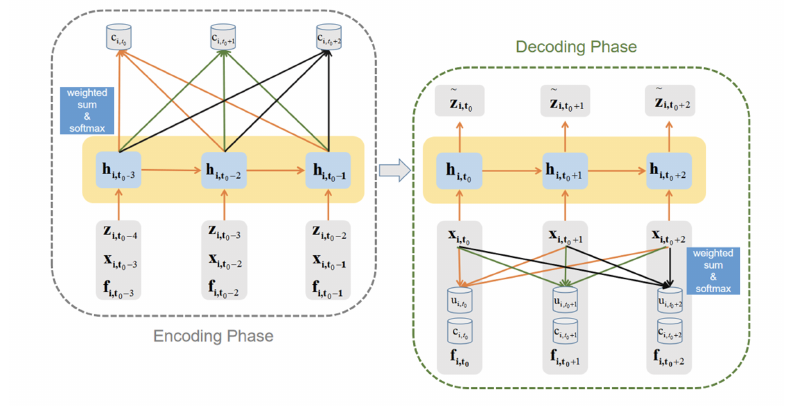
Figure 3. Dual-Attention in the improved seq2seq